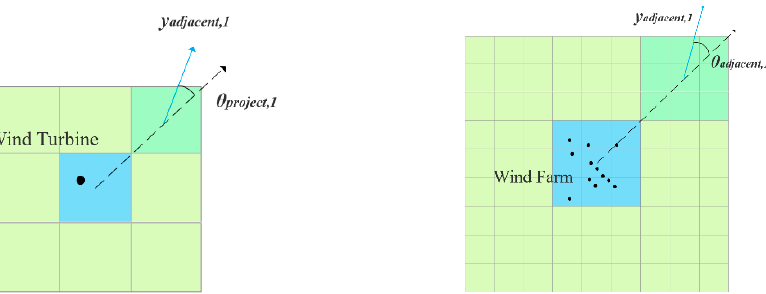
Figure 3. Illustration 1 on the adjacent node. ( 1 The blue area is the forecasting node where the wind turbine or wind farm is located; the green areas are the adjacent nodes).